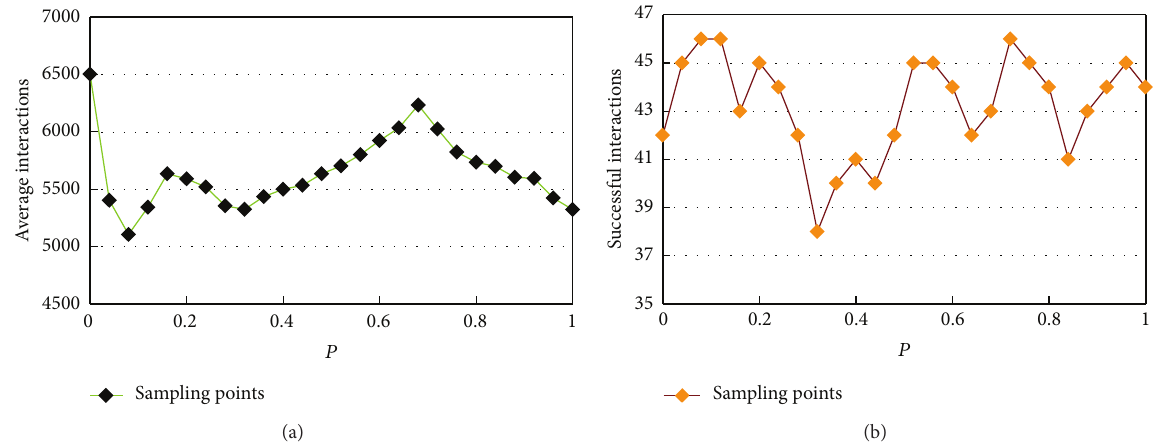
Figure 13: The convergence performance of the memristive neural network under different 𝑃 . (a) The relationship between iteration and rewiring probability. (b) The effective approximation number in 50 times simulations under varying rewiring